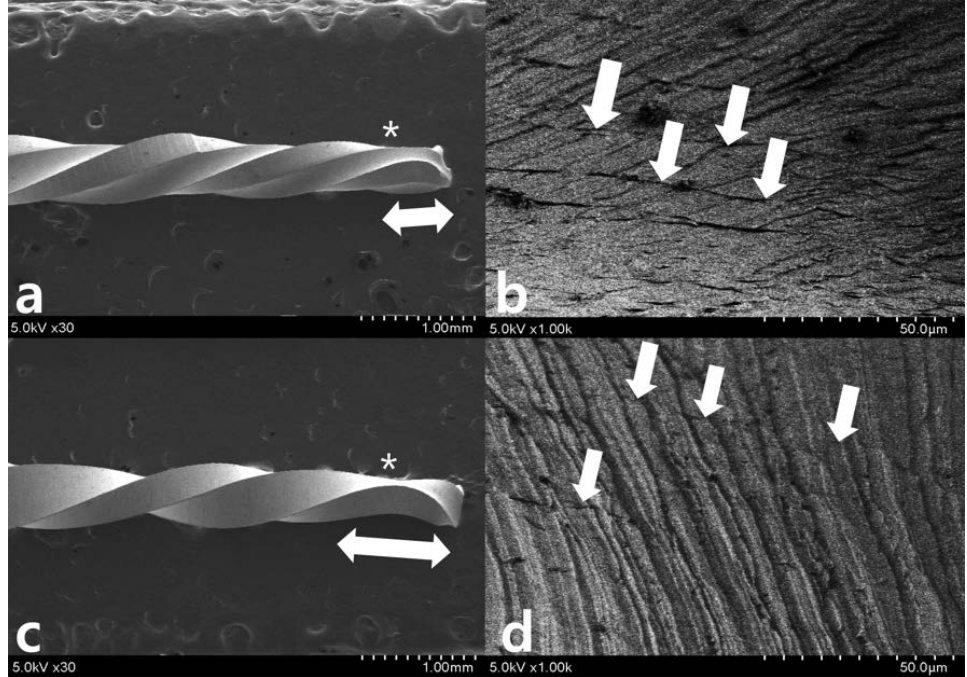
Figure 5. Scanning electron microscopy images after single continuous rotation test, WO ( a , b ) revealed much more evidence of micro-cracks ( white arrows ) than the WOG ( c , d ). The lateral aspect of fractured specimens showed not only numerous longitudinal micro-cracks but also distortion of the flute. The range of flute distortion ( double-headed arrows ) of WOG ( c ) was longer than that of WO ( a ).